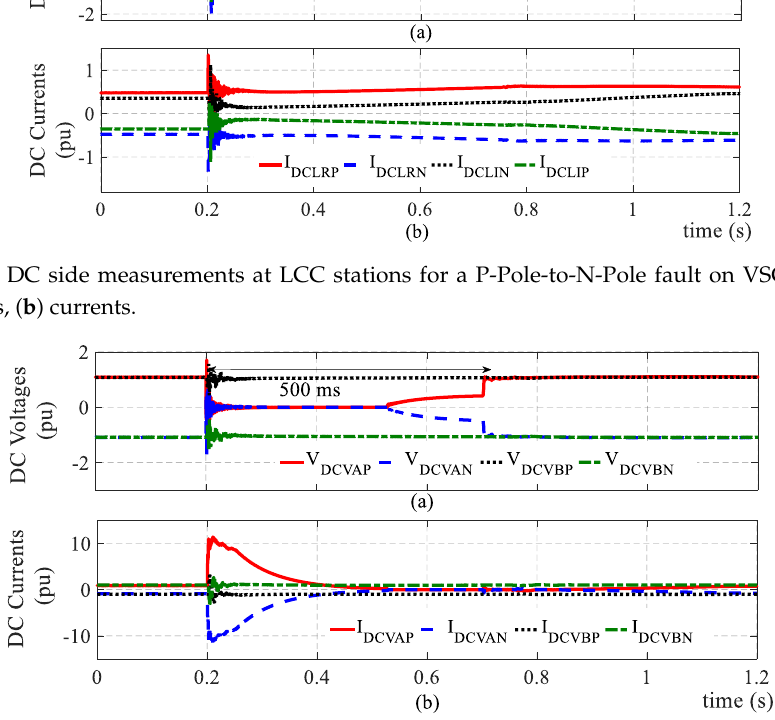
Figure 17. DC side measurements at VSC stations for a P-Pole-to-N-Pole fault on VSC branch-A ( a ) voltages, ( b ) currents.